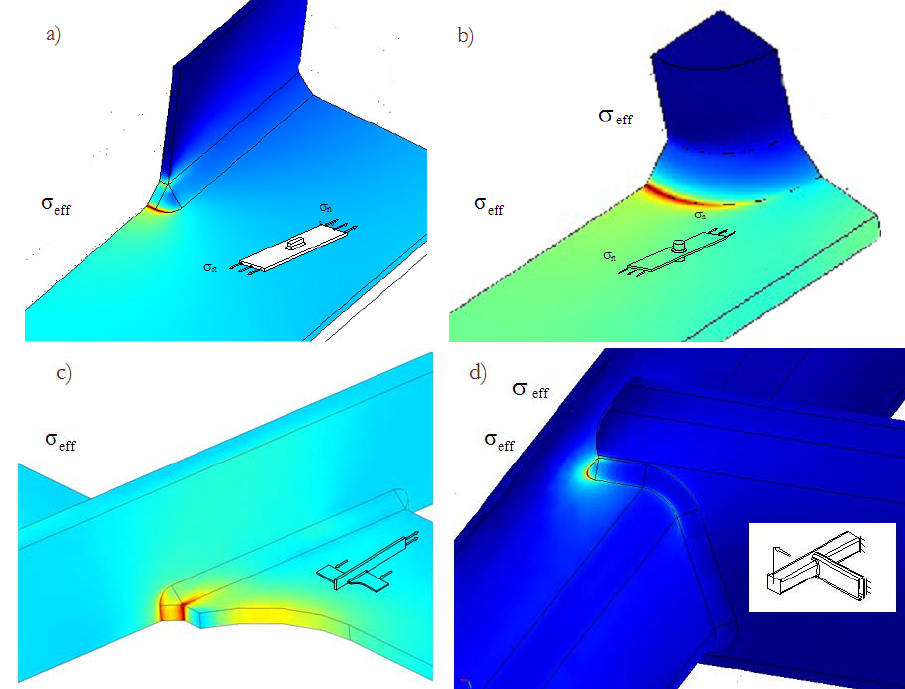
Figure 7: Modelli e risultati ottenuti in termini di tensione effettiva per piastre irrigidite sollecitate a trazione (massima tensione principale come tensione equivalente non locale, c=0.2